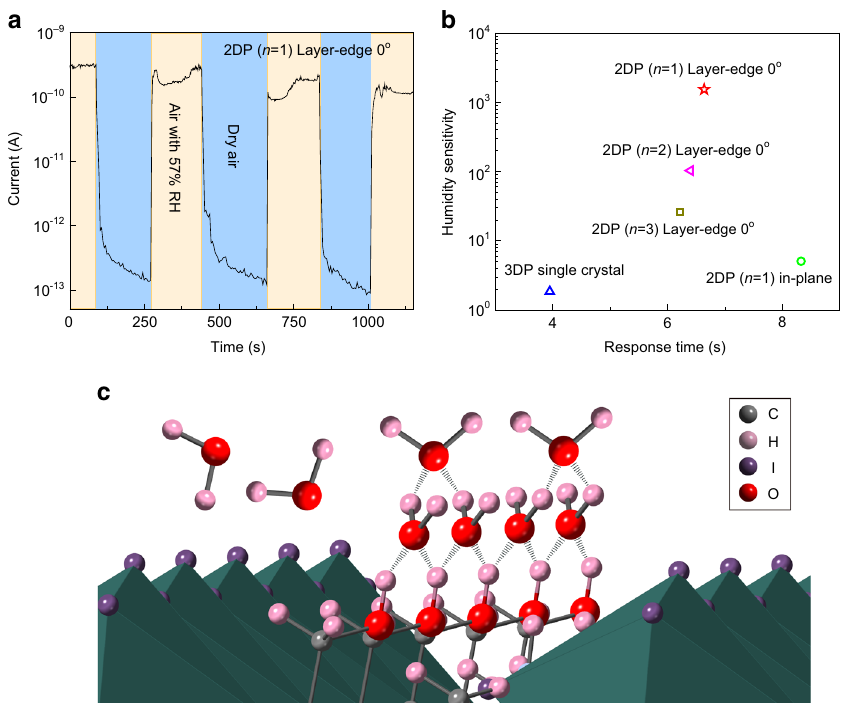
Fig. 5 Humidity sensitivity. a Dark current in dry air and with 57% humidity air in 2D perovskite layer-edge 0° device. b Humidity sensitivity and response time for devices on layer-edge 0° surface with different n , in-plane surface in 2D perovskites with n = 1, and (110) surface in 3D perovskites. c Schematic diagram of water absorption in layer-edge surface of 2D